Question: What kind of plot is shown here?
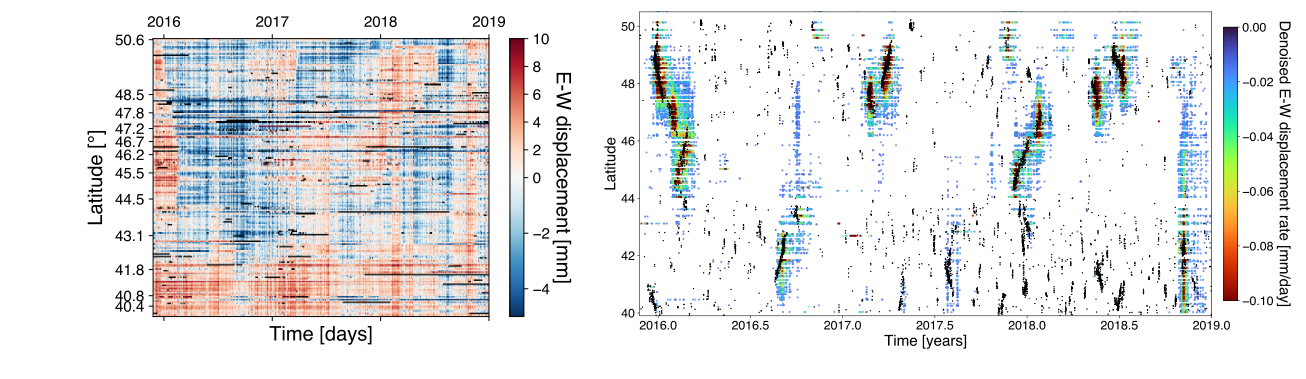
Answer: line